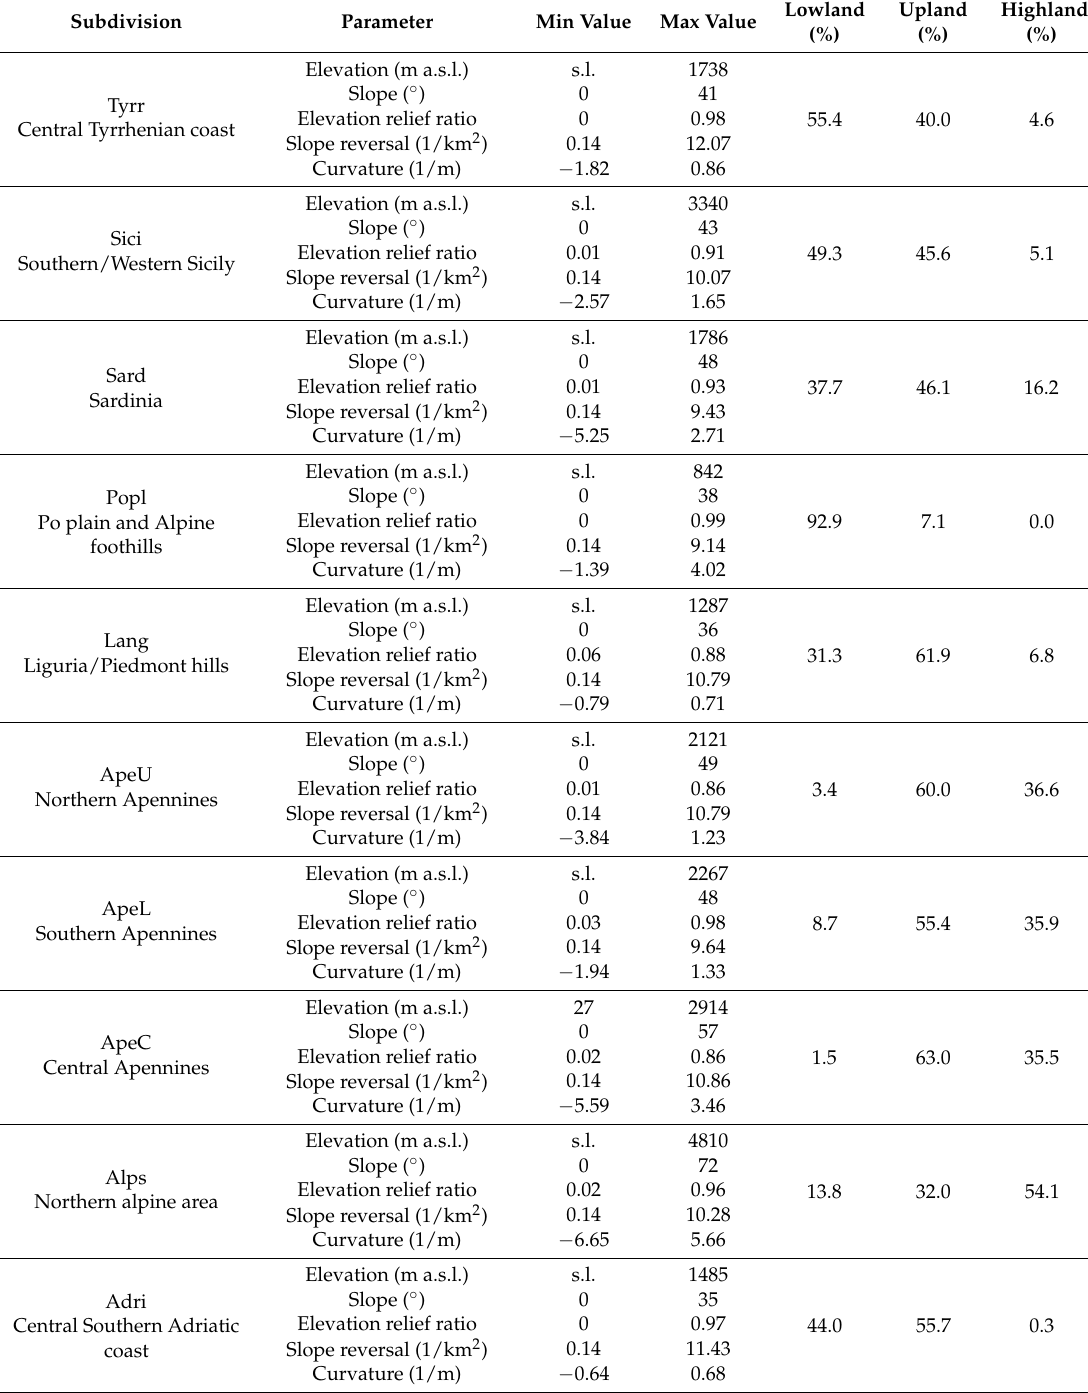
Table 2. Morphological parameters associated with morpho-climatological subdivisions. Values taken from Table 2 in